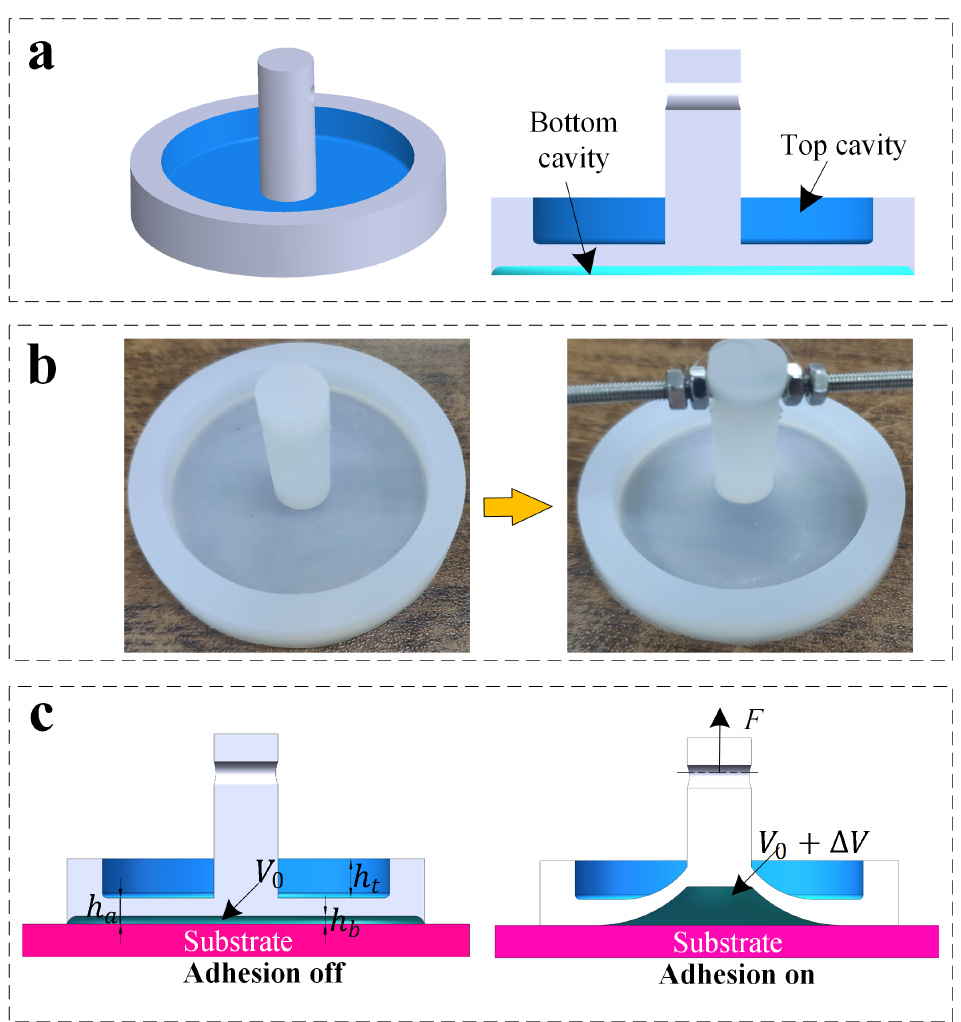
Figure 1. Structure and design of soft adhesion actuators. ( a ) structural design of double-layer actuator with ring groove on the top and cavity underneath; ( b ) The prototype actuator (left) deforms into a dome shape after applying a vertical load (right); ( c ) schematic of the operation for actuator upon external load; adhesion-off state (left), adhesion-on state